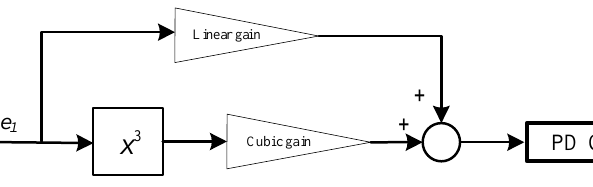
Figure 2. General controller scheme.